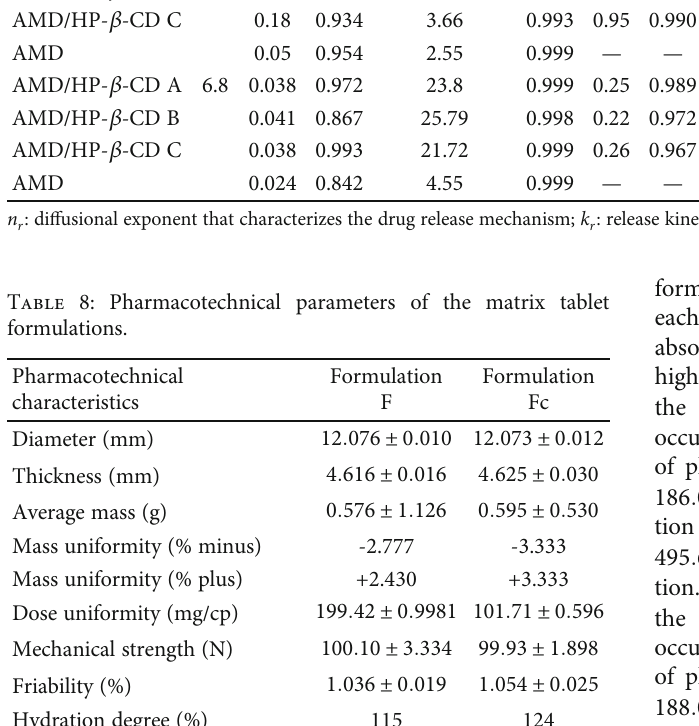
Table 7: Kinetic parameters of the AMD release from the inclusion complexes and for the AMD dissolution in the two media. Samples AMD/HP- β -CD A 1.2